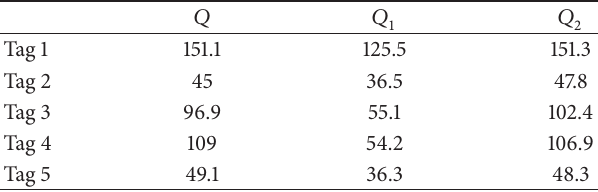
Figure 6: The complete testing circuit of the STC antenna.